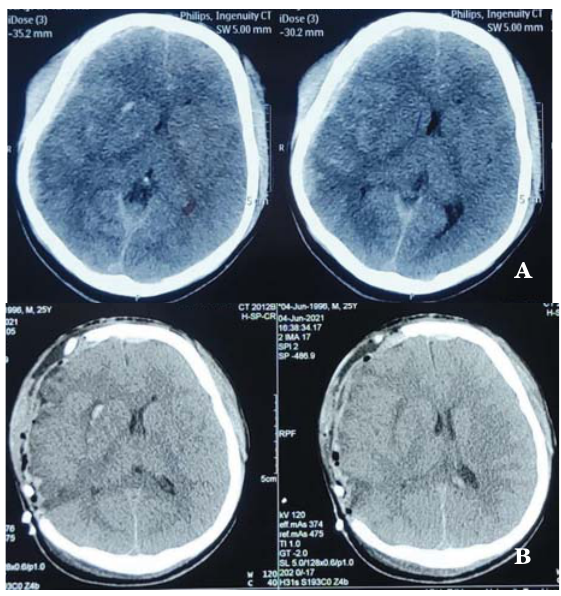
Figure 1. CT scan of the patient with right (cid:73)(cid:85)(cid:82)(cid:81)(cid:87)(cid:82)(cid:87)(cid:72)(cid:80)(cid:83)(cid:82)(cid:85)(cid:82)(cid:83)(cid:68)(cid:85)(cid:76)(cid:72)(cid:87)(cid:68)(cid:79)(cid:3) (cid:36)(cid:70)(cid:88)(cid:87)(cid:72)(cid:3) (cid:54)(cid:39)(cid:43)(cid:3) (cid:90)(cid:76)(cid:87)(cid:75)(cid:3) (cid:86)(cid:76)(cid:74)(cid:81)(cid:76)(cid:191)(cid:70)(cid:68)(cid:81)(cid:87)(cid:3) midline shift (A). Postoperative CT scan of the same patient showing evidence of DC and improvement in the midline shift (B). The patients underwent either a frontotemporoparietal craniectomy or a bifrontal craniectomy based on the site